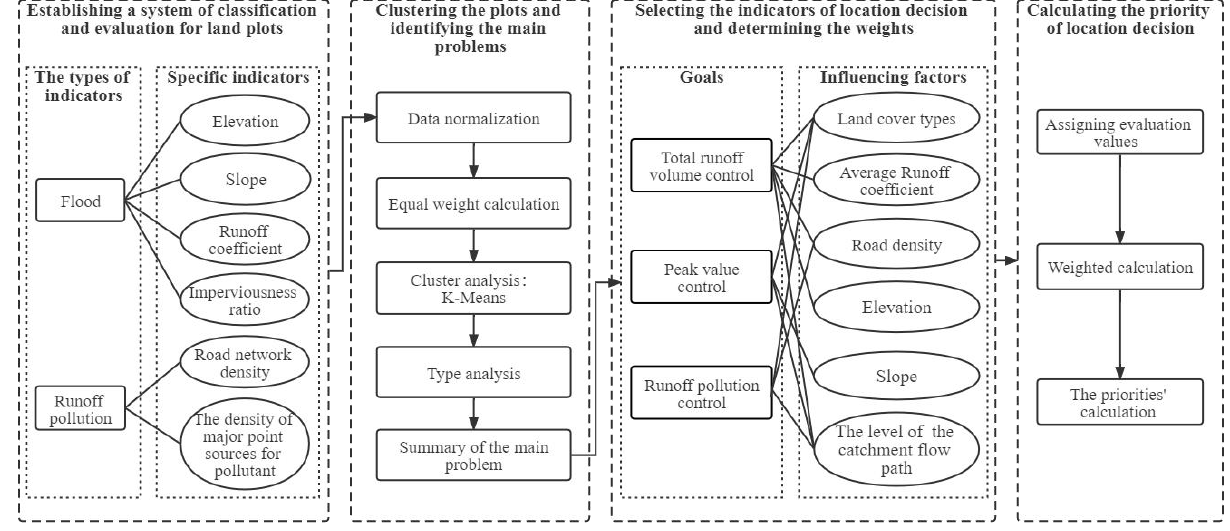
Figure 2. The overall framework of the technical method of this study.